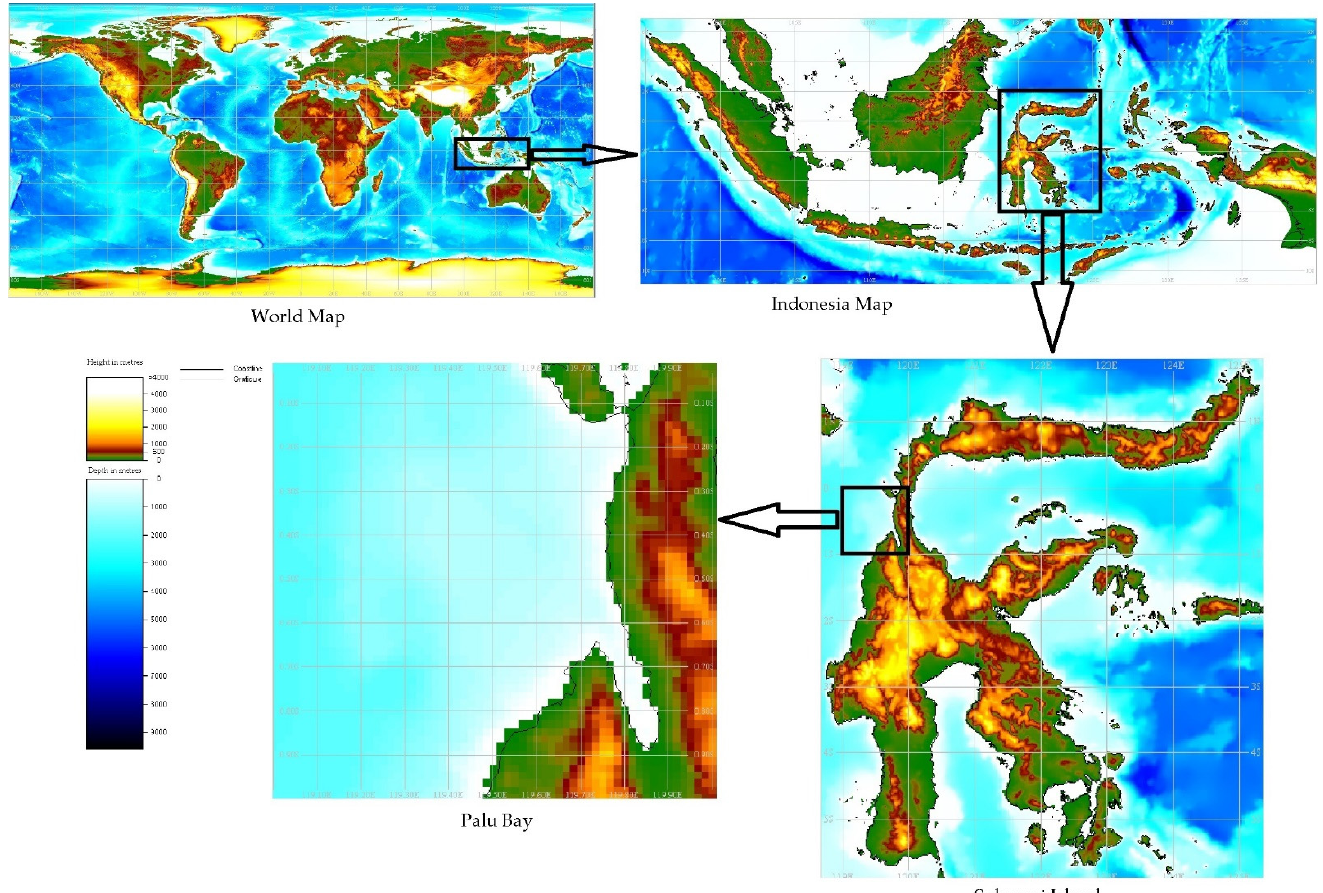
Figure 1. Location of Palu bay, Sulawesi island, Indonesia on the world map (source: GEBCO).